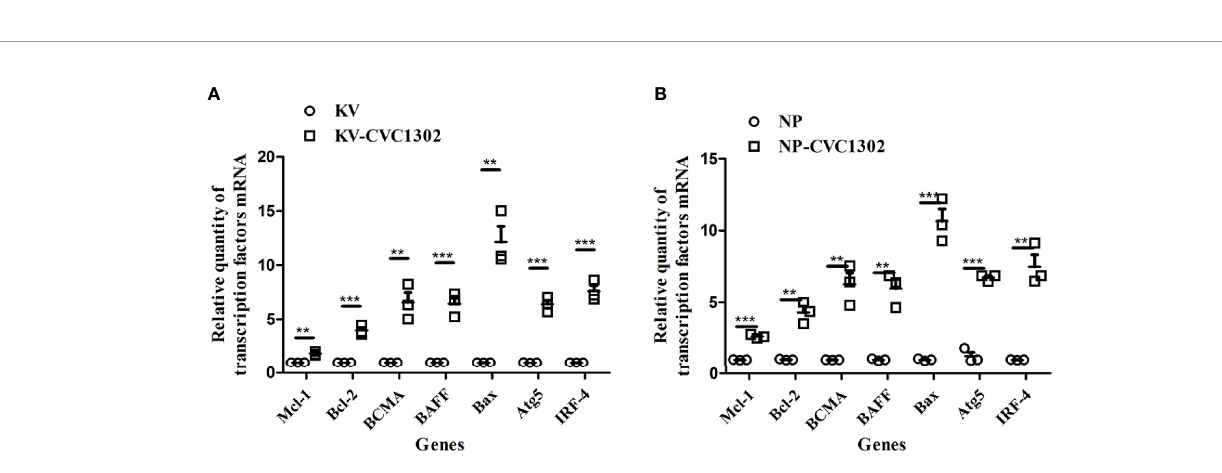
FIGURE 7 | Effect of CVC1302 adjuvantation on the expression of anti-apoptotic regulators essential for extending the life-time of LLPCs. Bone-marrow cells were isolated at 90 dpi, and RNA was extracted from these cells by using Trizol. The expression levels of anti-apoptotic regulators [ (A) represents test 1, (B) represents test 2] were detected by real- time RT-PCR. Results are expressed as the mean ± SEM. ** P < 0.01, *** P <